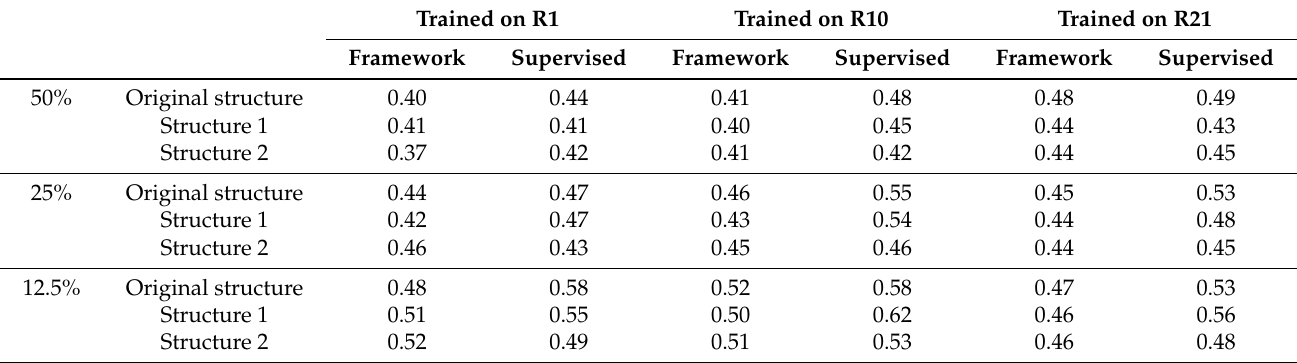
Table 8. Comparison of the training time for different structures of the networks after FS.